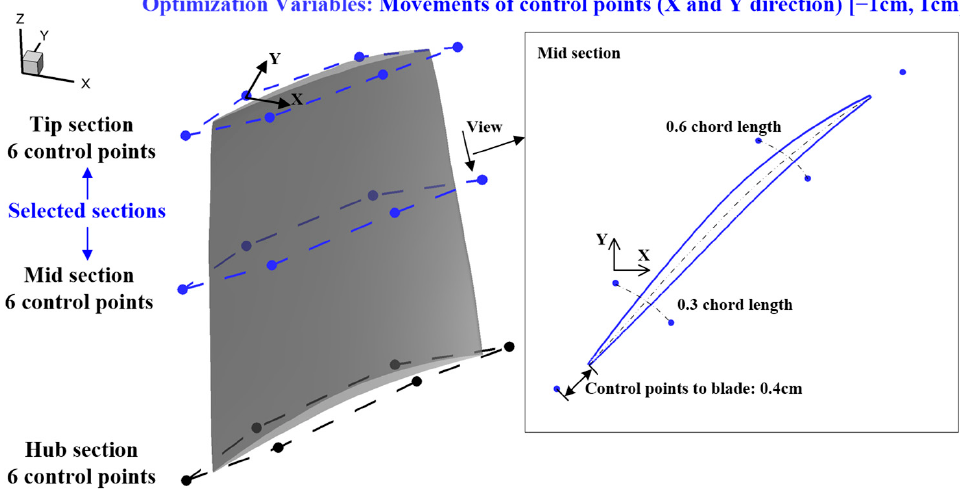
Figure 7. The diagram of the control point settings (the blue points indicate the selected optimization control